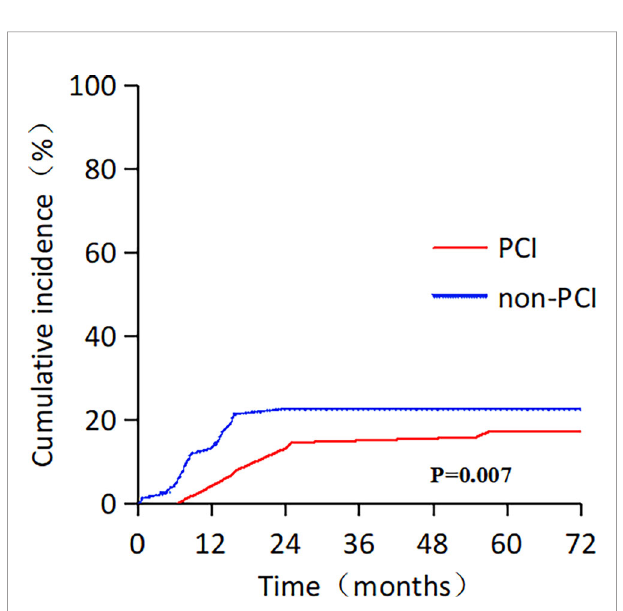
FIGURE 2 | Cumulative incidence rate of distant brain metastasis, with death as competing risk, among patients with limited-stage small cell lung